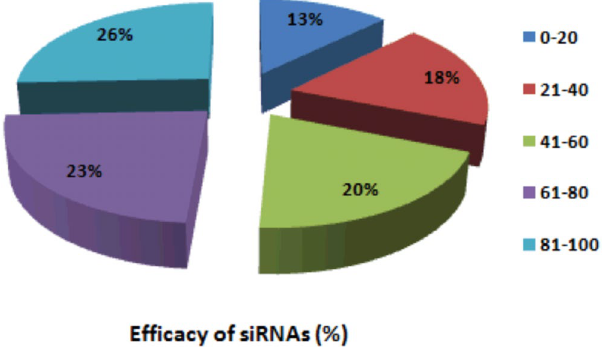
Figure 2. Percentage of different si/shRNAs included in the database suppressing the target gene expression to different levels